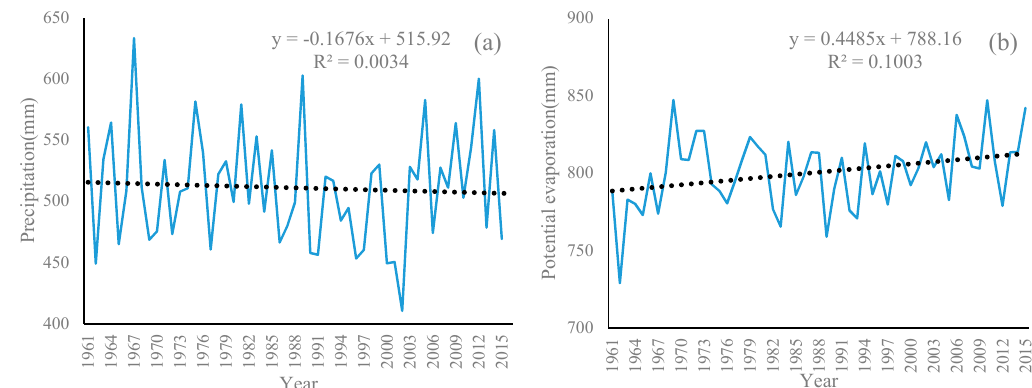
Figure 3. Changing trend of annual average precipitation ( a ) and potential evaporation ( b ) from 1961 to 2015 in the source area of the Yellow River basin.